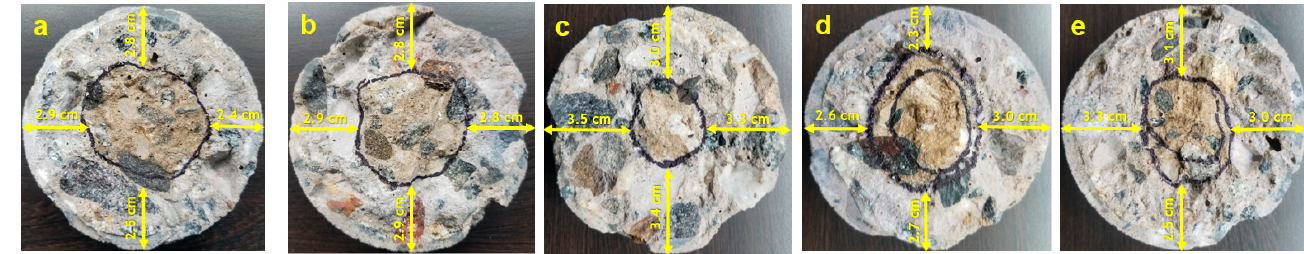
Figure 7. Chloride ion penetration in concrete at 182 days of exposure: ( a ) Blank, ( b ) Neem, ( c ) Sika CNI, ( d ) Eucon CIA and ( e ) DCI.